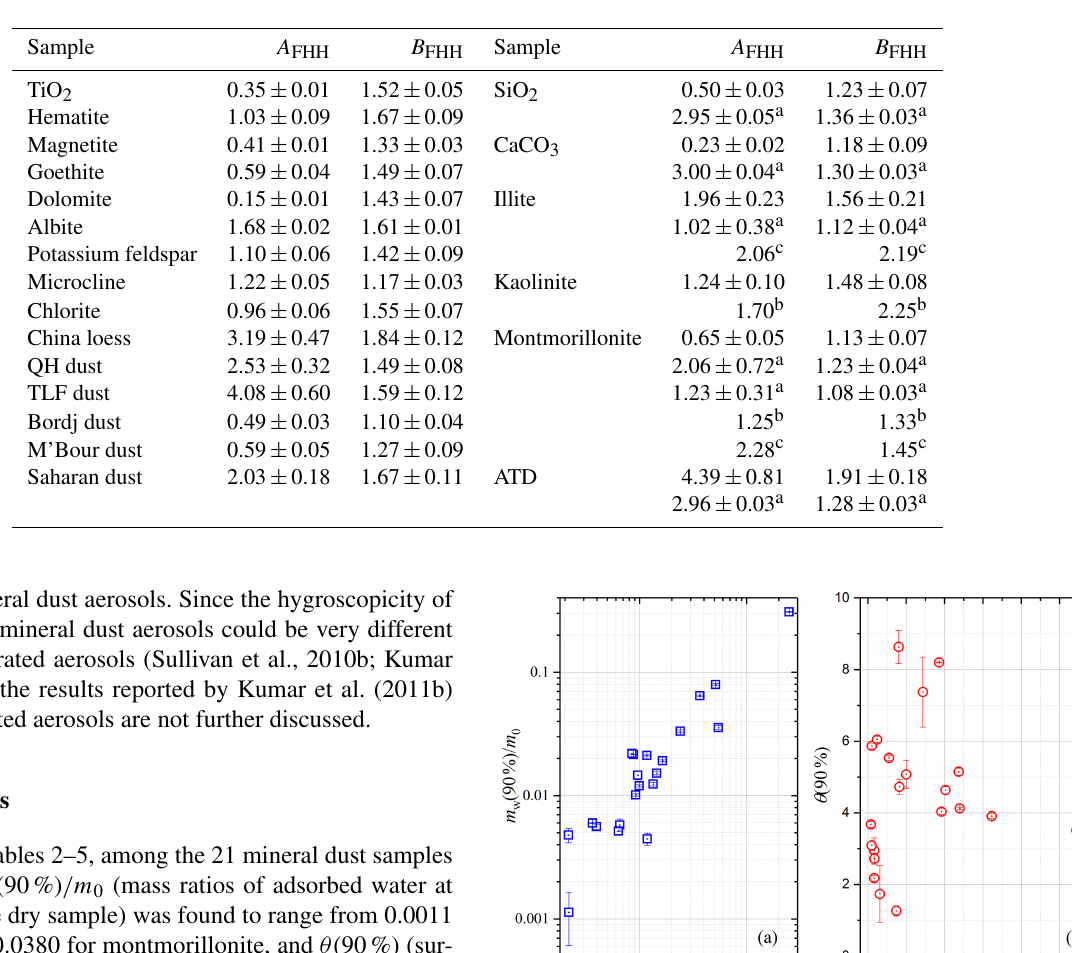
Table 6. Comparison of A FHH and B FHH values determined in our work for mineral dust with those reported in previous studies ( a Kumar et al., 2011a; b Hung et al., 2015; c Hatch et al., 2019).